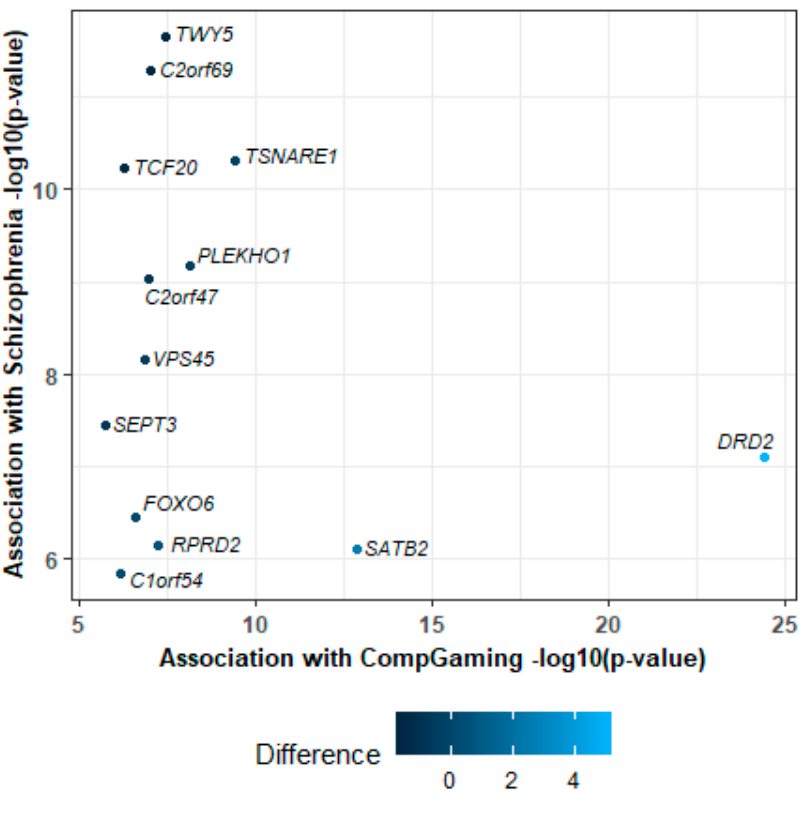
Figure 2. Genes significantly associated with both schizophrenia (SCZ) and UKB Field ID 2237 “ plays computer games ” ( CompGaming ) after Bonferroni correction ( p < 2.64 × 10 − 6 ). The difference in per-gene effects ( z- score CompGaming minus z -score SCZ ) on each trait is color-coded.